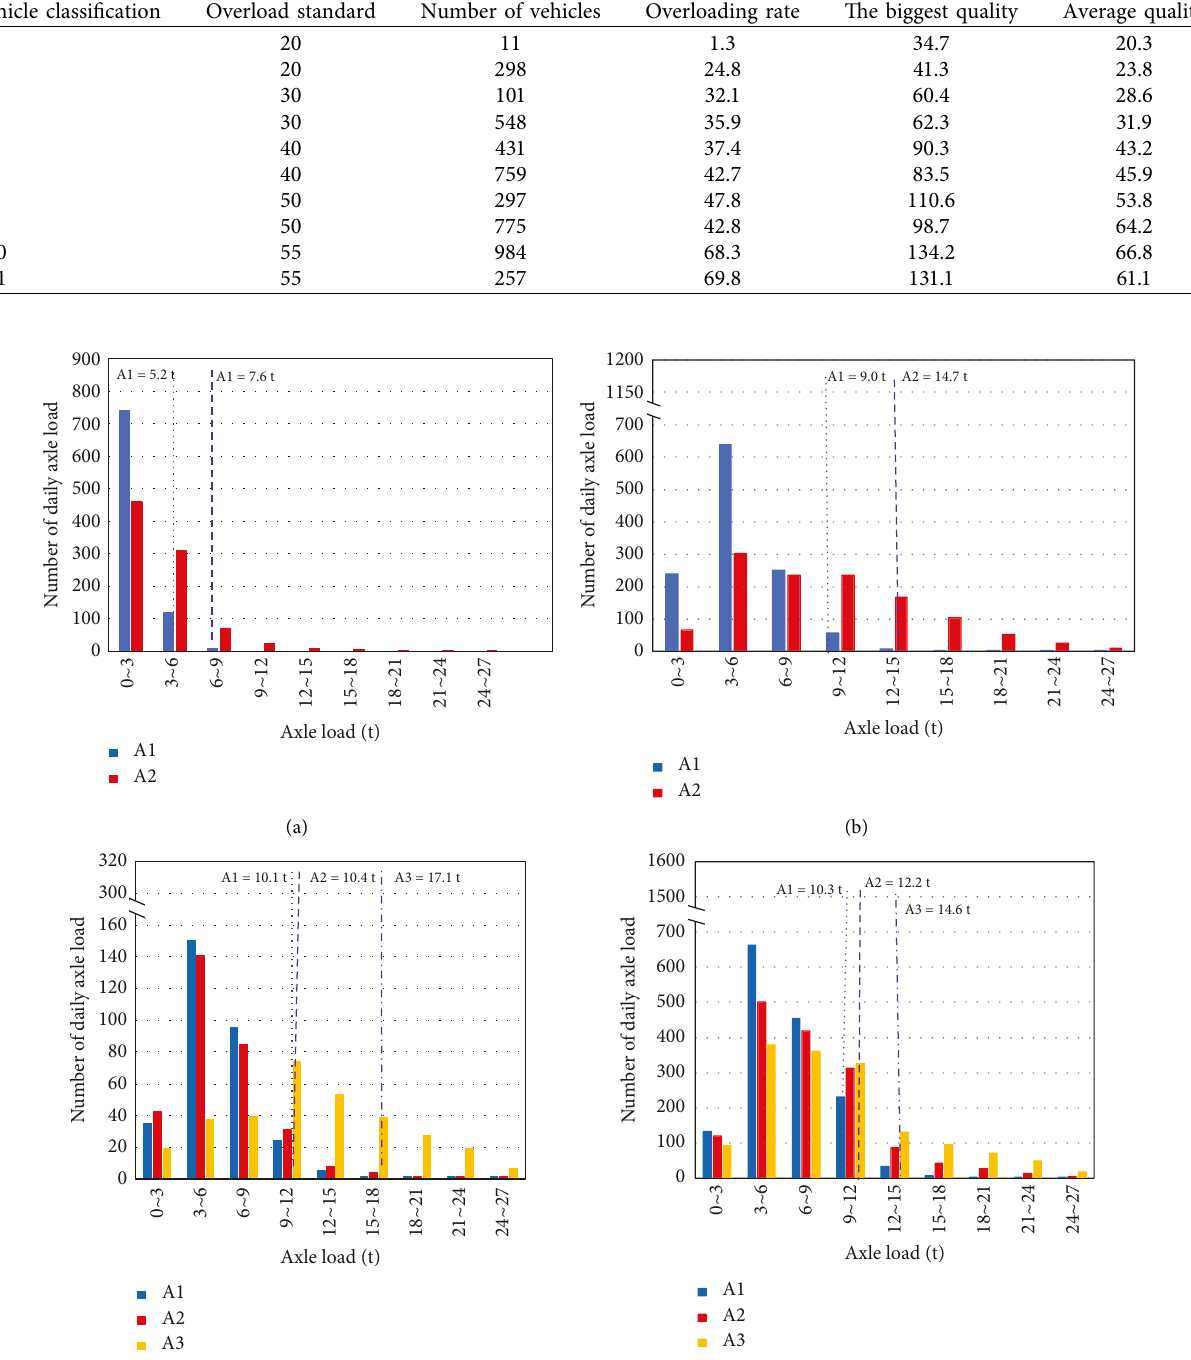
Table 3: Statistics of overweight